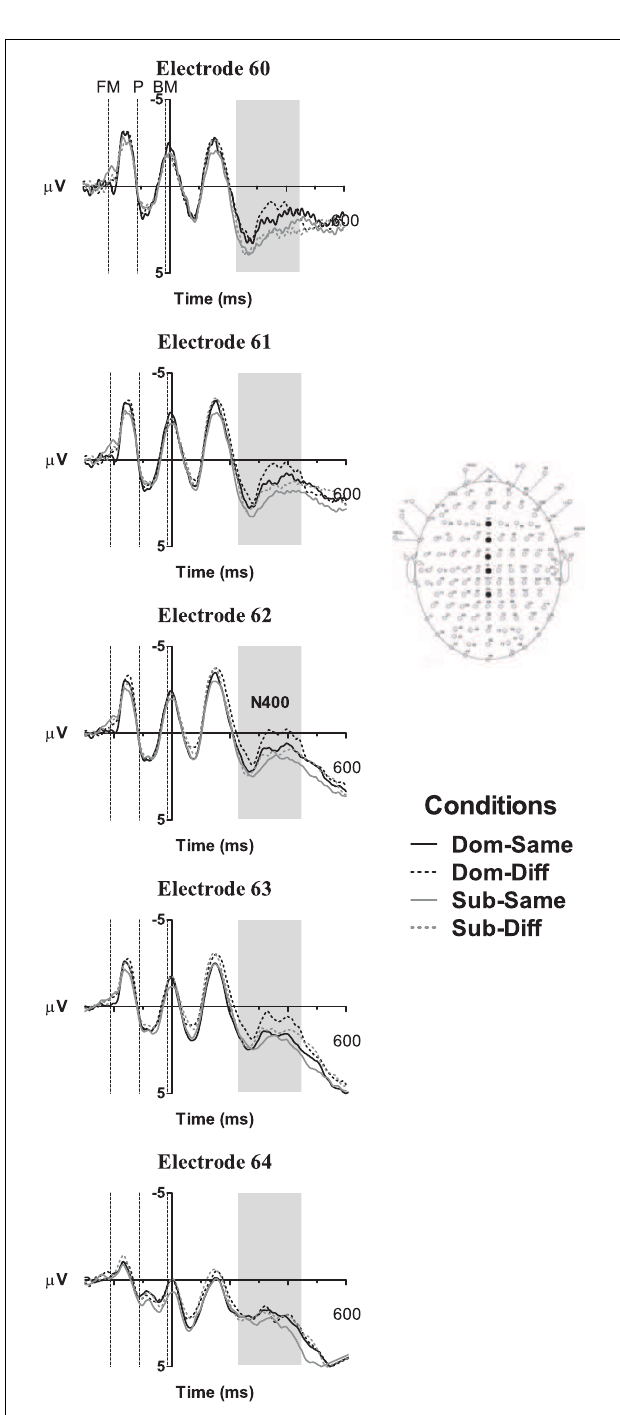
FIGURE 4 | Grand averaged ERP waveforms showing effects of radical dominance and radical position at the N400 component located at the centro-parietal midline electrodes and shaded in gray. Dom-Same, dominant radical character with prime radical in same position; Dom-Diff, dominant radical character with prime radical in different position; Sub-Same, subordinate radical character with prime radical in same position; Sub-Diff, subordinate radical character with prime radical in different position. Dotted vertical lines indicate the onset of the forward mask (FM), prime (P), and backward mask